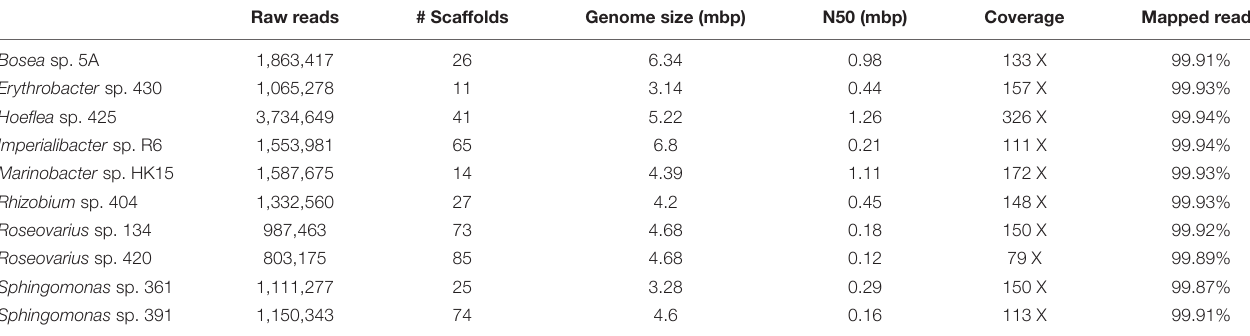
TABLE 1 | Overview of bacterial genomes used in this study and corresponding assembly statistics. Raw reads # Scaffolds Genome size (mbp) N50 (mbp) Coverage Mapped reads